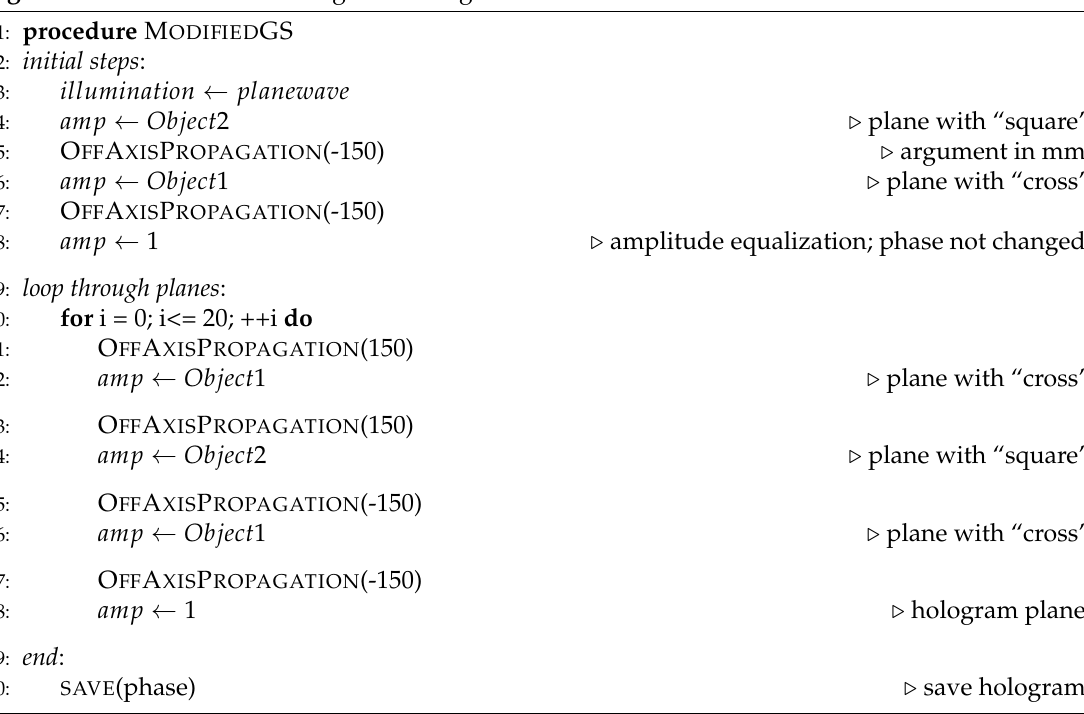
Figure 1. Designing a synthetic hologram: numerical simulation scheme. Prop indicates propagation at particular distance. Algorithm 1 Modified Gerchberg–Saxton